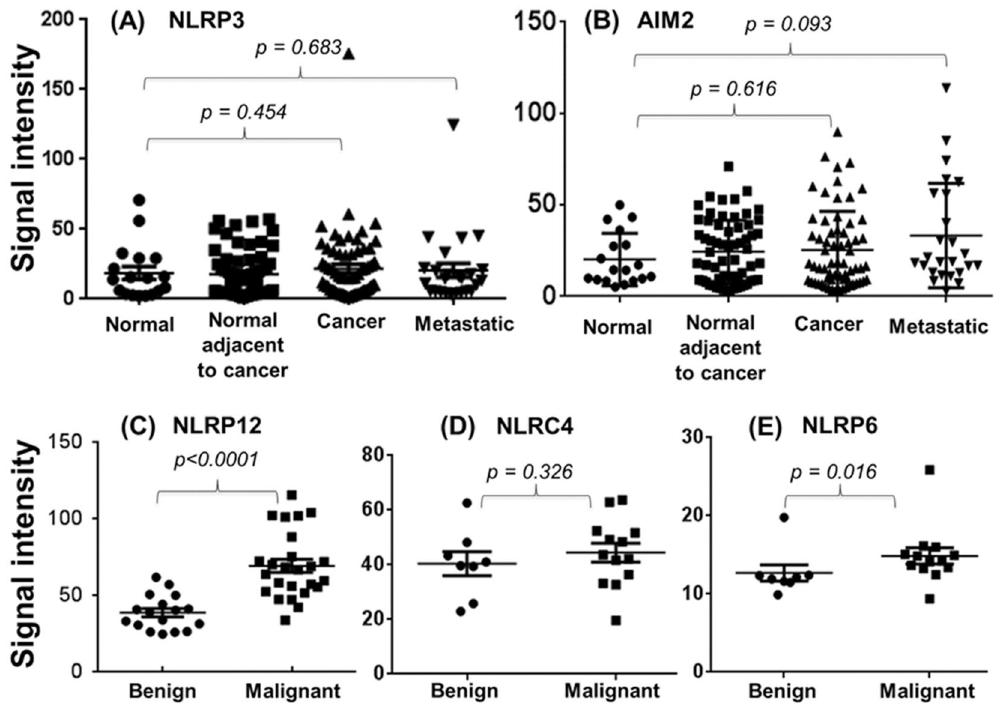
Figure 1. Analysis of gene expression based on microarray datasets from the GEO profiles. The raw values were obtained from the datasets representing a maximum number of prostate samples. Unpaired, non-parametric, Mann-Whitney test was used to analyze the significant level of ( A ) NLRP3; ( B ) AIM2; ( C ) NLRP12; ( D ) NLRC4; and ( E ) NLRP6 expression between benign and malignant prostate tissue samples. The values are expressed as the standard error of the mean (m ±